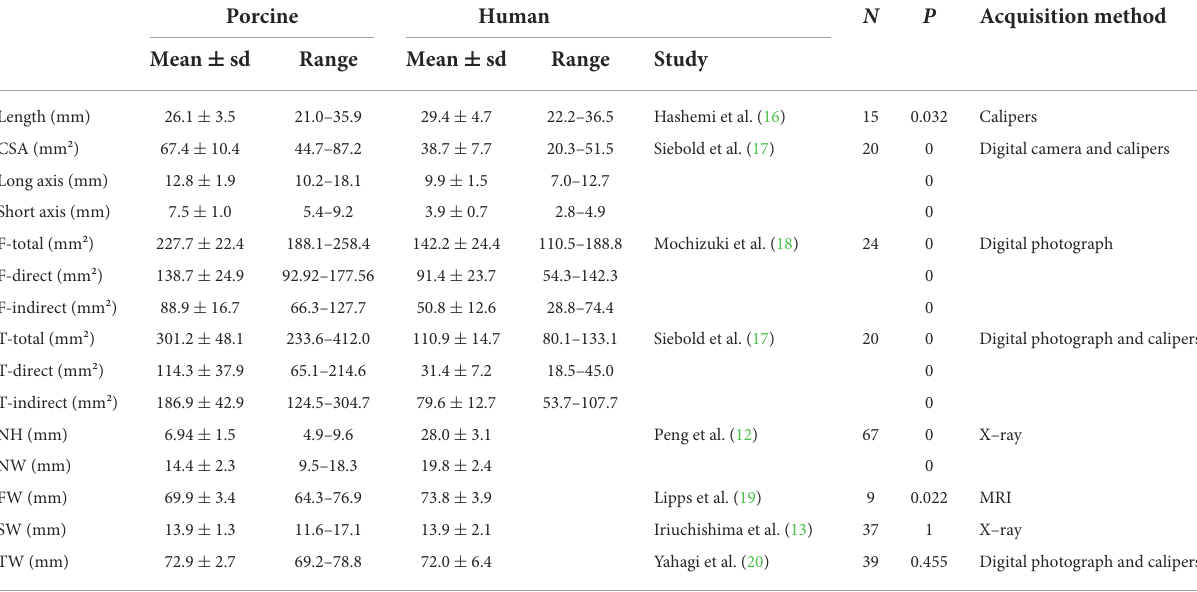
TABLE 1 Quantitative comparison of the ACL and bone features in porcine and human knees. Porcine Human N